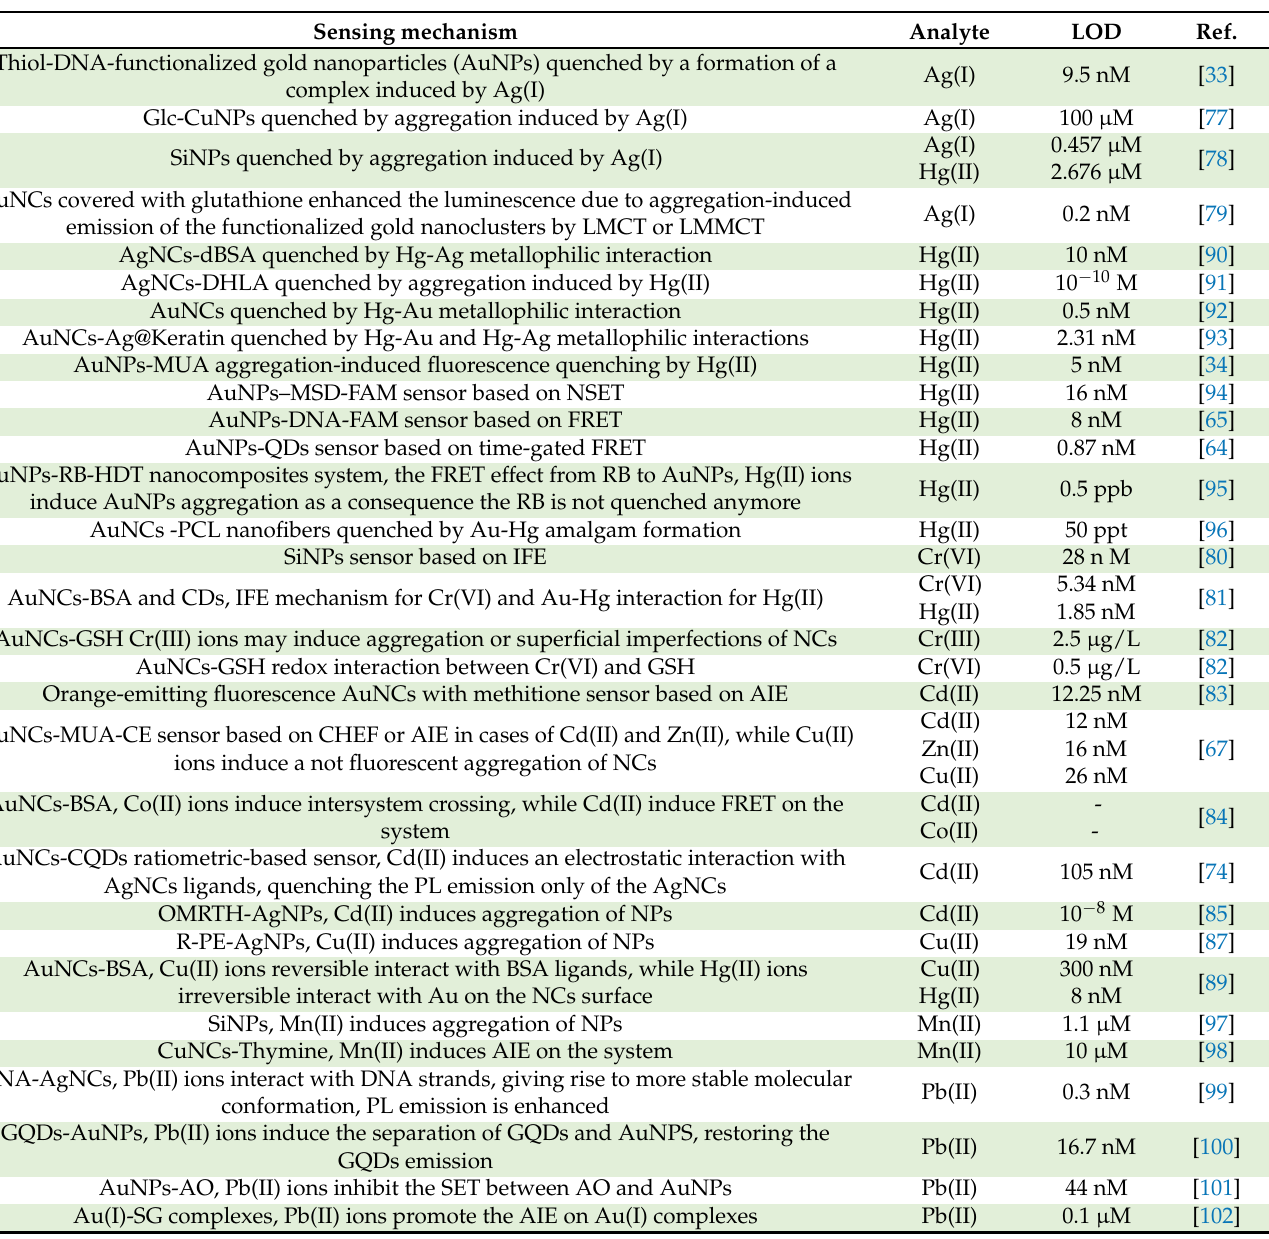
Table 3. List of noble metal nanomaterials used for heavy metal ions detection and their limit of detection (LOD). Sensing mechanism Analyte LOD